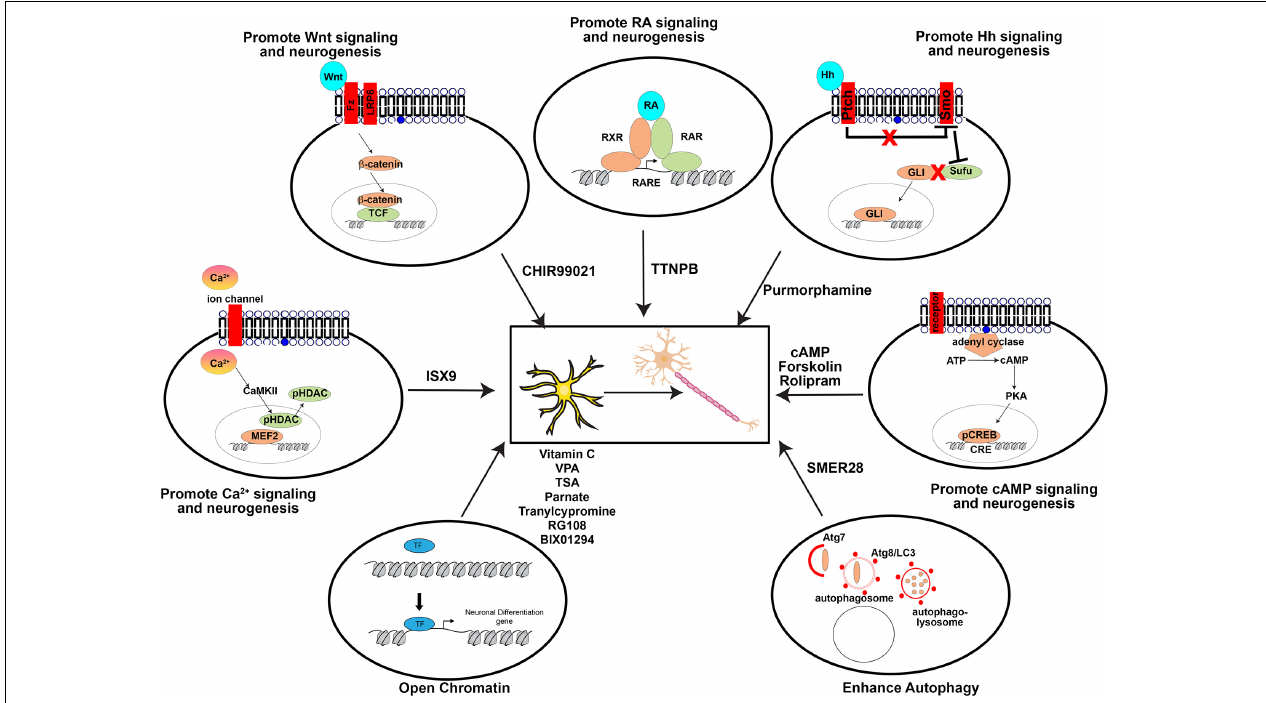
FIGURE 3 | Pathways activated by small molecules to aid direct neuronal reprogramming. A summary of the agonists/antagonists used in neuronal reprogramming cocktails that activate critical signaling pathways or cellular